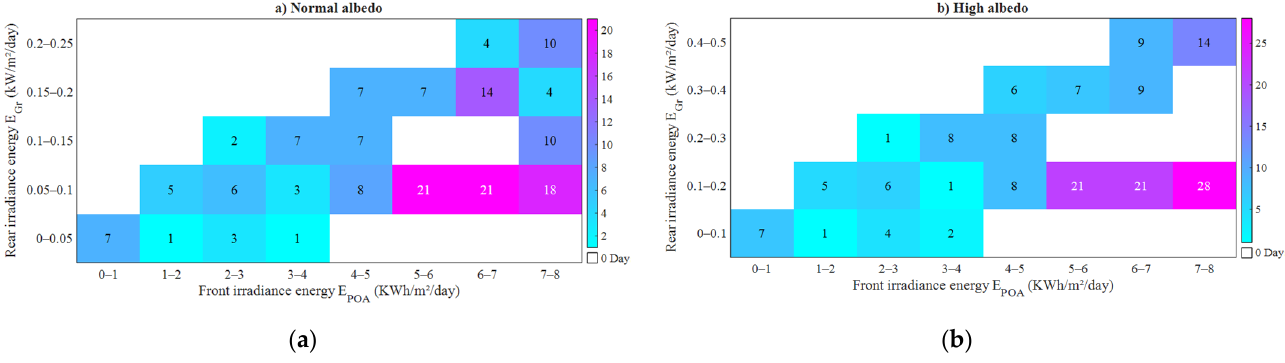
Figure 10. Heatmap of the daily energies of the rear and front irradiances. ( a ) Daily rear irradiance distribution with normal albedo. ( b ) Daily rear irradiance distribution with high albedo.